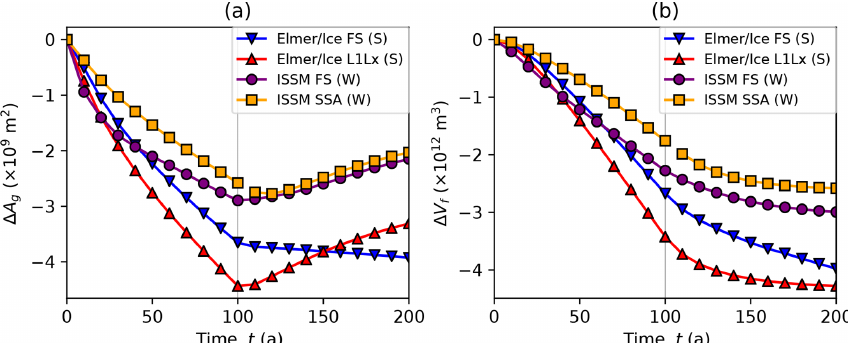
Figure 10. Comparison of full-Stokes and vertically integrated models in the Ice1r ( t ≤ 100a) and Ice1ra ( t ≥ 100a) experiments. Panel (a) shows the change in grounded area (cid:49)A g and panel (b) the change in volume above flotation (cid:49)F f . “FS” indicates a full-Stokes model, “(S)” the Schoof (2005) sliding law, and “(W)” the Weertman (1957) sliding